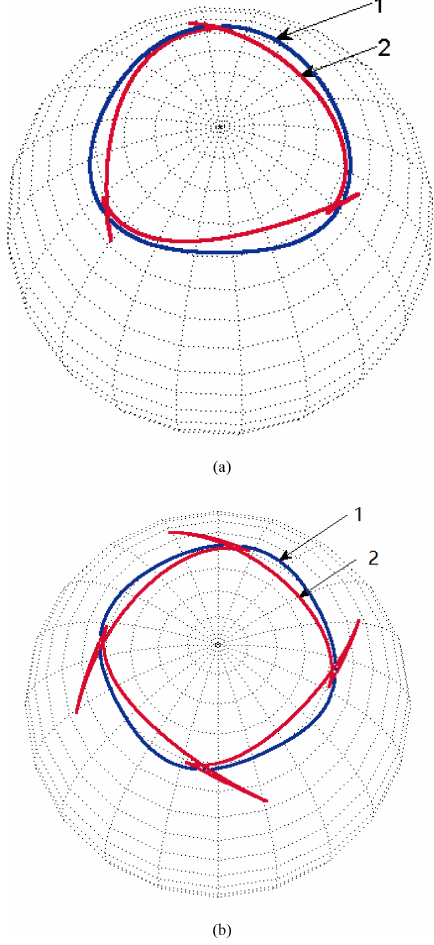
Figure 6. Spherical base curve of tooth profile curve of high order noncircular bevel gear (Large eccentricity). (a) φ = 5 ◦ , λ = 74 ◦ , n = 3. (b) φ = 3 ◦ , λ = 74 ◦ , n = 4. 1 – Pitch curve. 2 – Spherical base curve of right tooth profile.